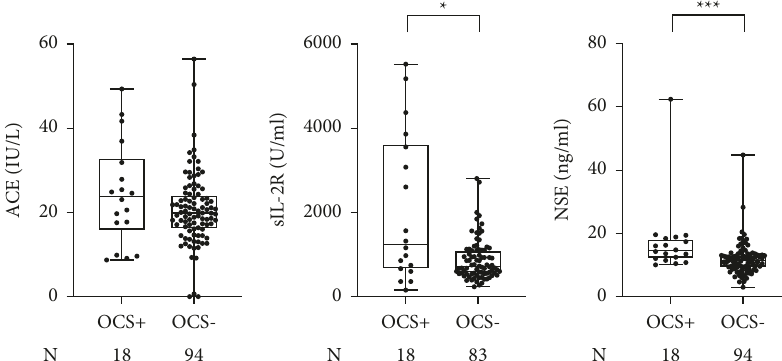
Figure 4: Comparisons of the serum levels of NSE, sIL-2R, and ACE between sarcoidosis patients who had been treated with OCS and those who had never been treated with OCS. ∗ P < 0 . 05, ∗∗∗ P < 0 . 001. Table 4: Likelyhood of oral corticosteroid use based on serum ACE, sIL-2R, and NSE in sarcoidosis. Parameter Cutoff value No. of OCS-treated cases/OCS-untreated cases Odds ratio 95% CI P value ACE ( + ) vs. ACE ( −